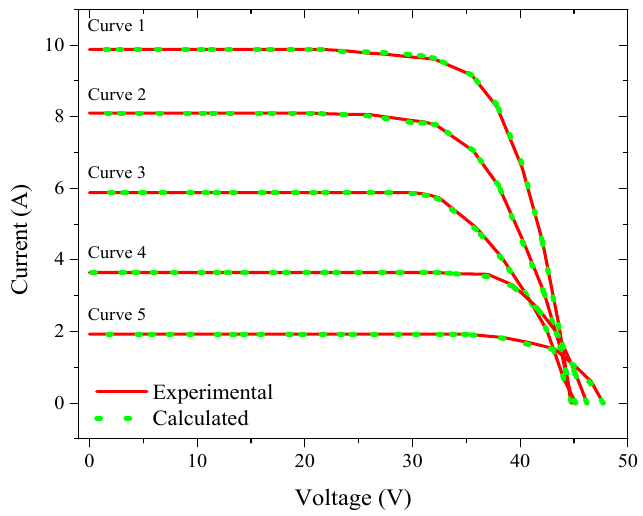
Figure 15. I–V curves of DDM, JKM330P-72 PV module for all respective curves.